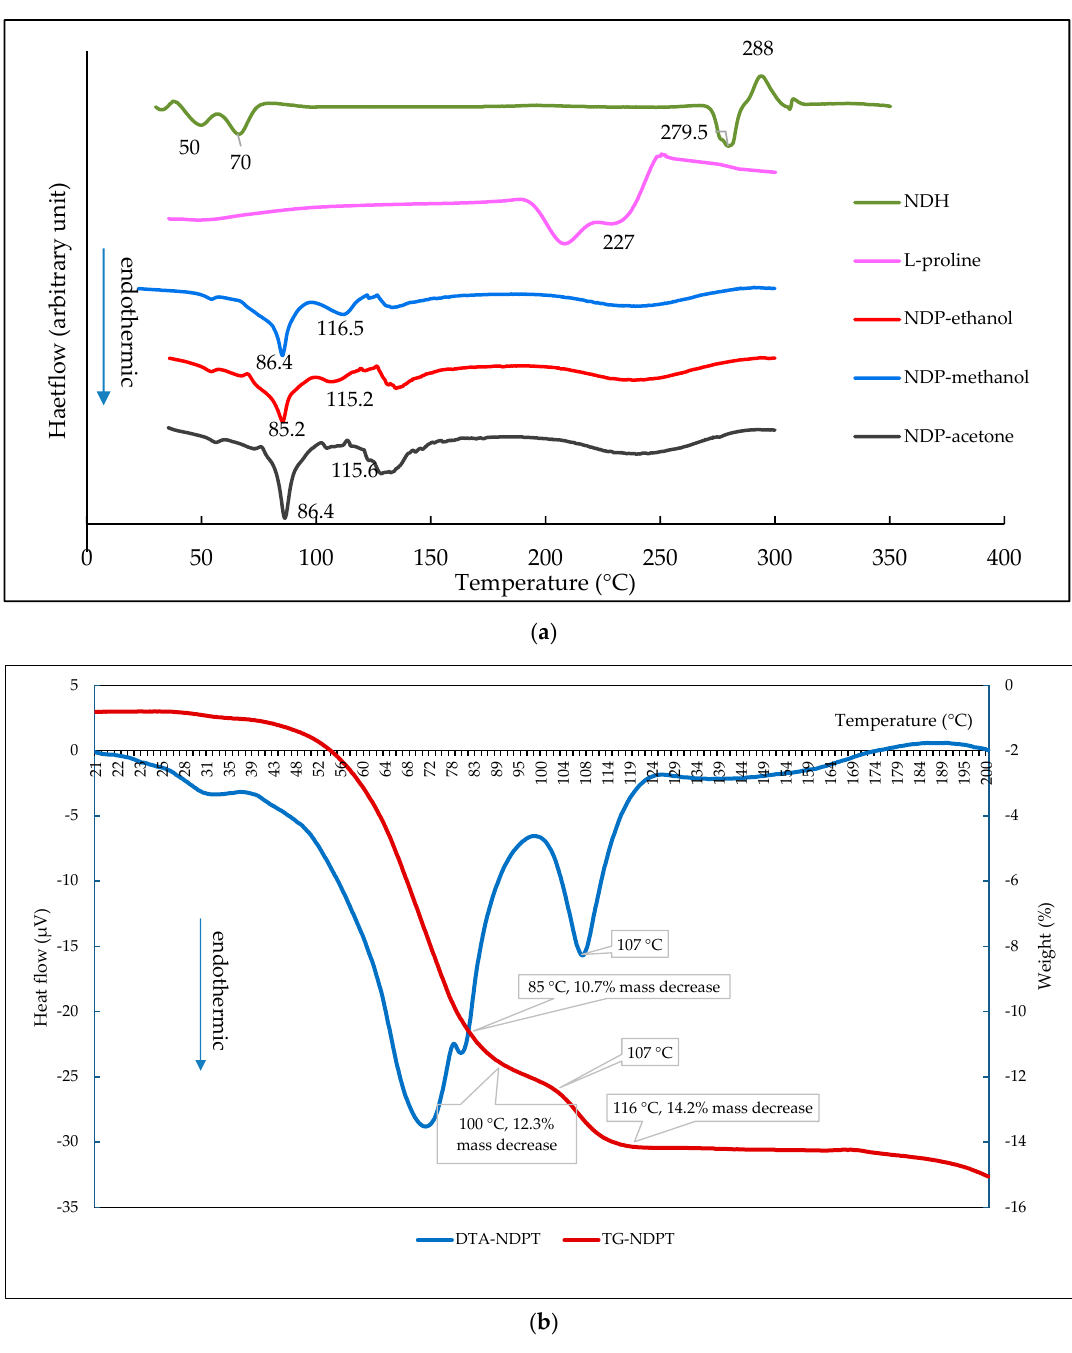
Figure 4. ( a ) Differential scanning calorimetry (DSC) thermogram of diclofenac sodium hydrate (NDH); L-proline (LP); and NDP cocrystals from acetone, ethanol, and methanol, respectively. ( b ) DTA and TG thermogram of NDP, shown ~ 14.2% mass decrease or equal to 4 water molecules.